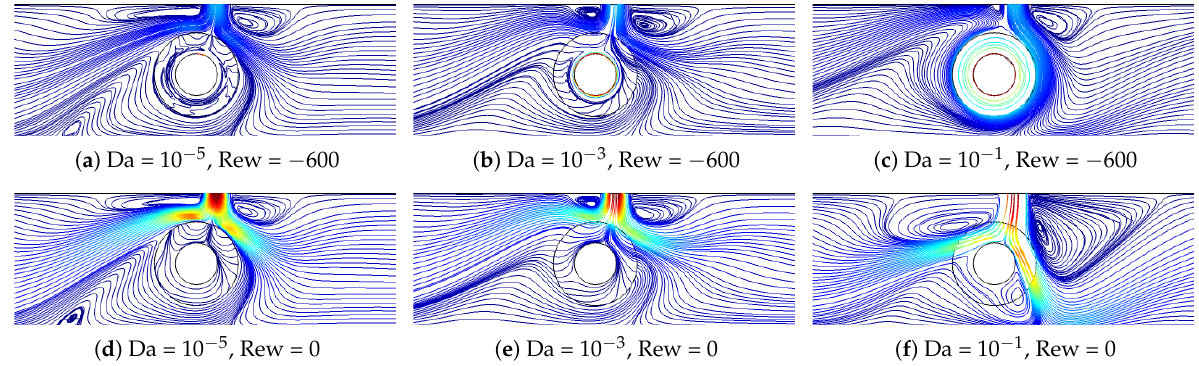
Figure 9. Impacts of permeability of the object on the streamline distributions at two Rew values (Ha = 10,Mx = − 1,AR = 0.5).